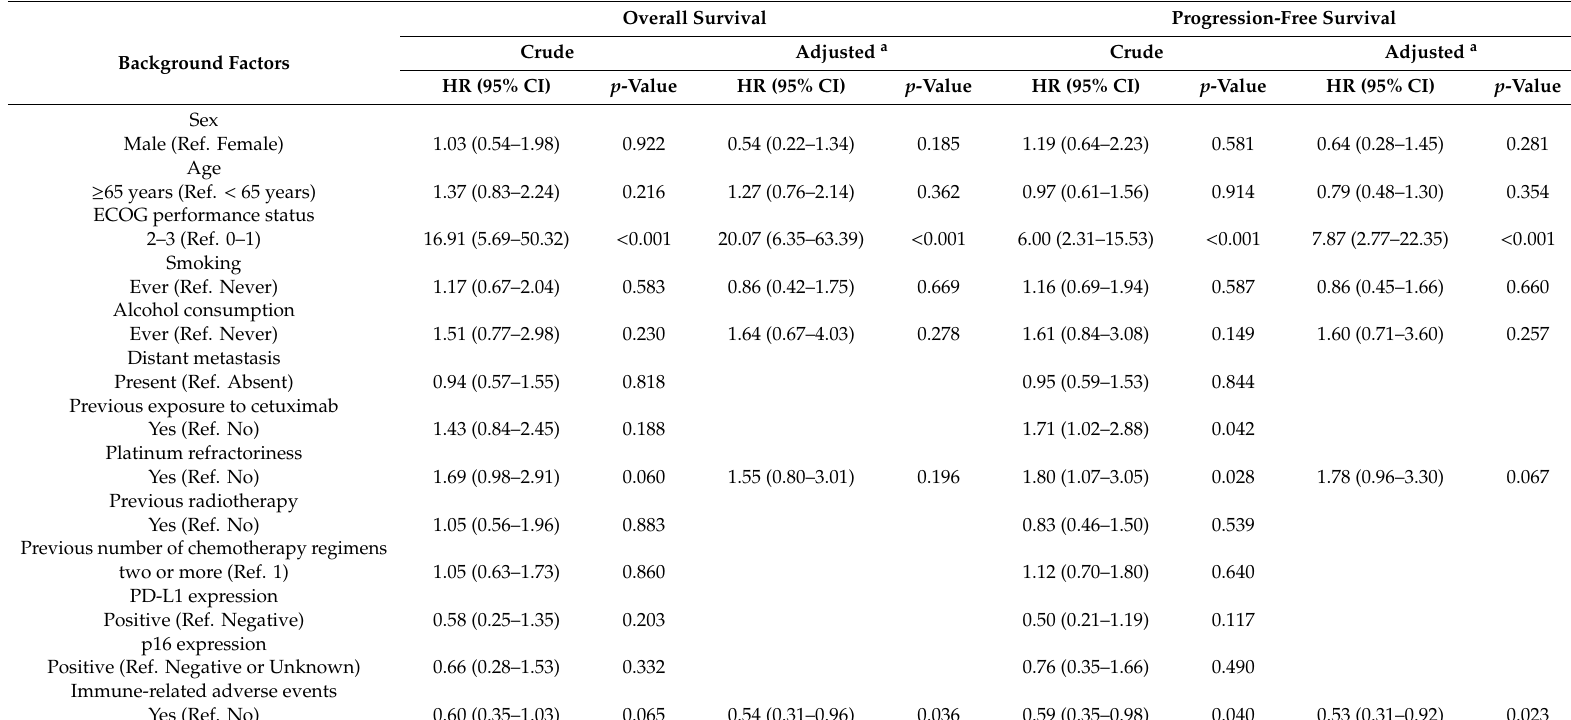
Table 4. Univariate and multivariate analyses of background factors for overall survival and progression-free survival. Overall Survival Progression-Free